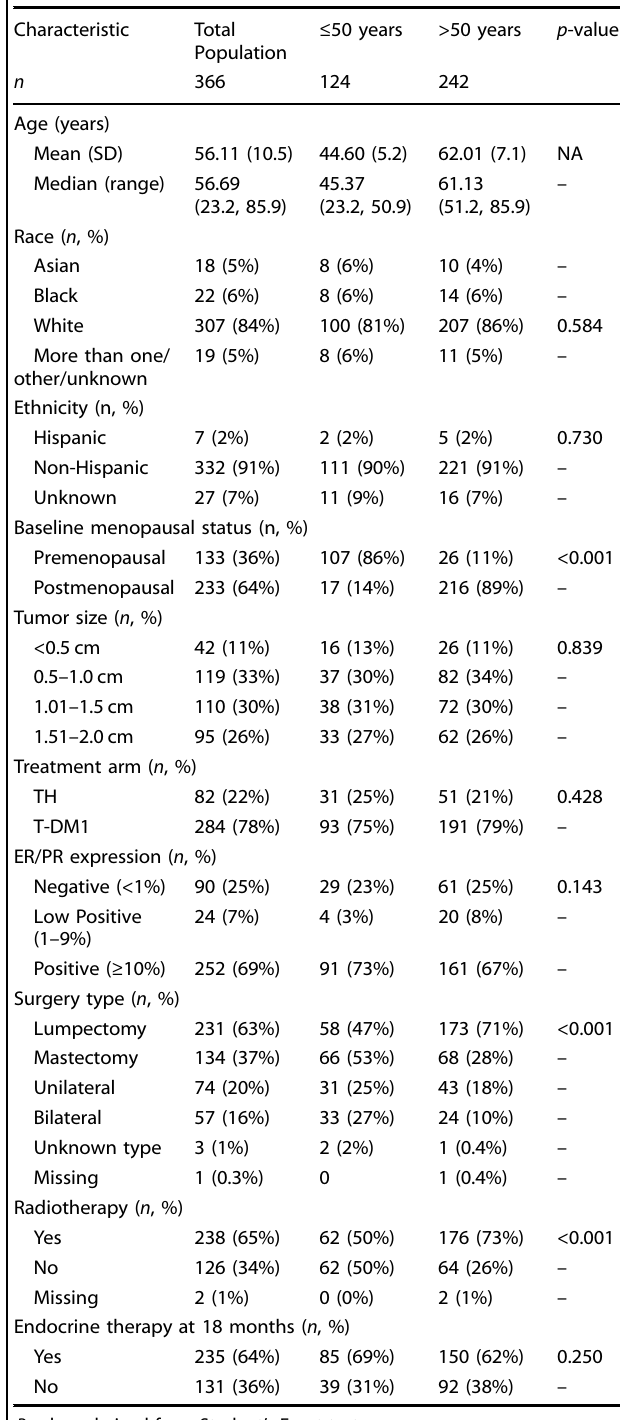
Table 1. Baseline characteristics by age